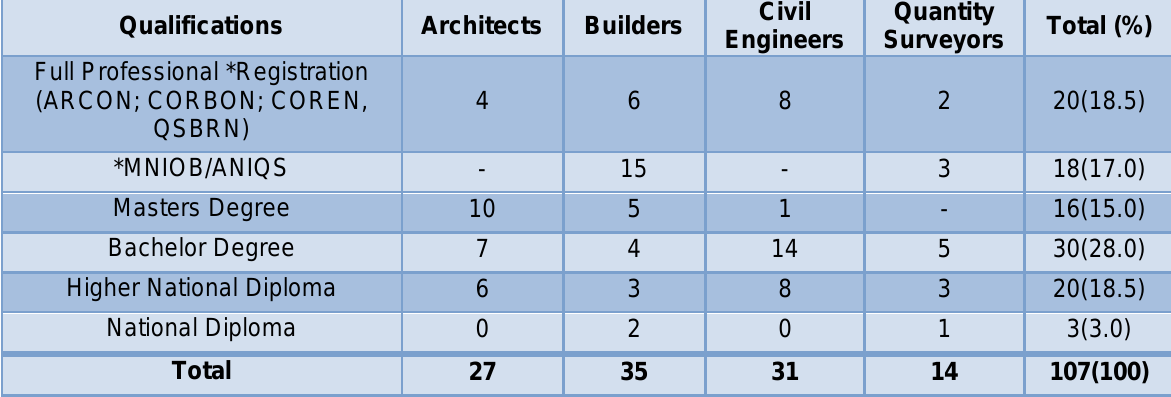
Table 2 Highest academic and professional qualifications of the